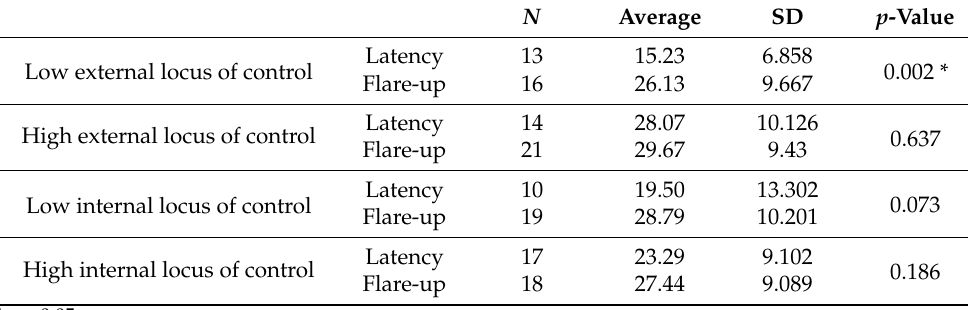
Table 1. Stress averages according to the locus of control.